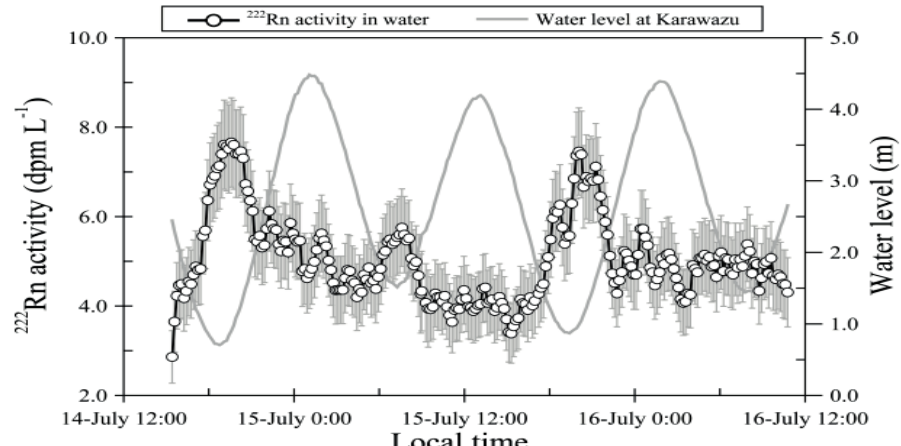
Fig. 3 Temporal changes in 222 Rn and sea level at